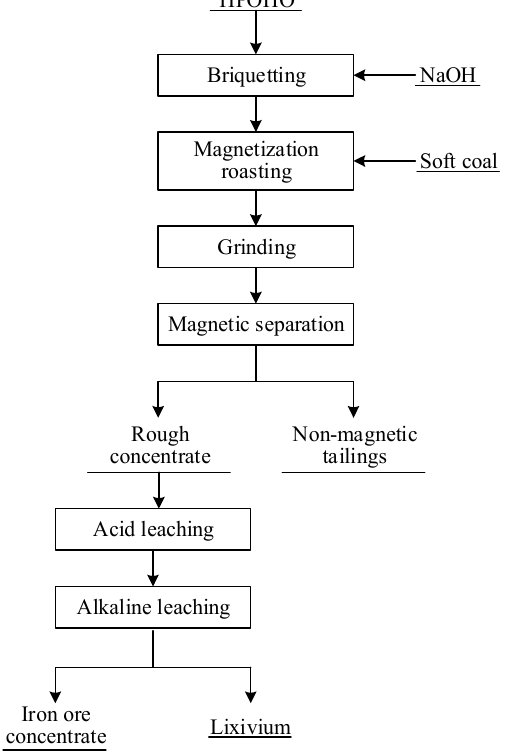
Figure 4. Experimental flowchart to upgrade the HPOHO.